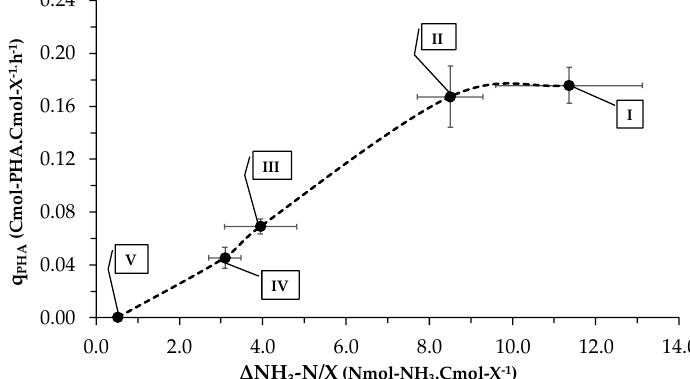
Figure 5. Relation between the specific PHA storage rate ( qPHA ) and the specific ammonia–nitrogen consumption ( ∆ NH 3 - N/X ), during the different periods (I – V).